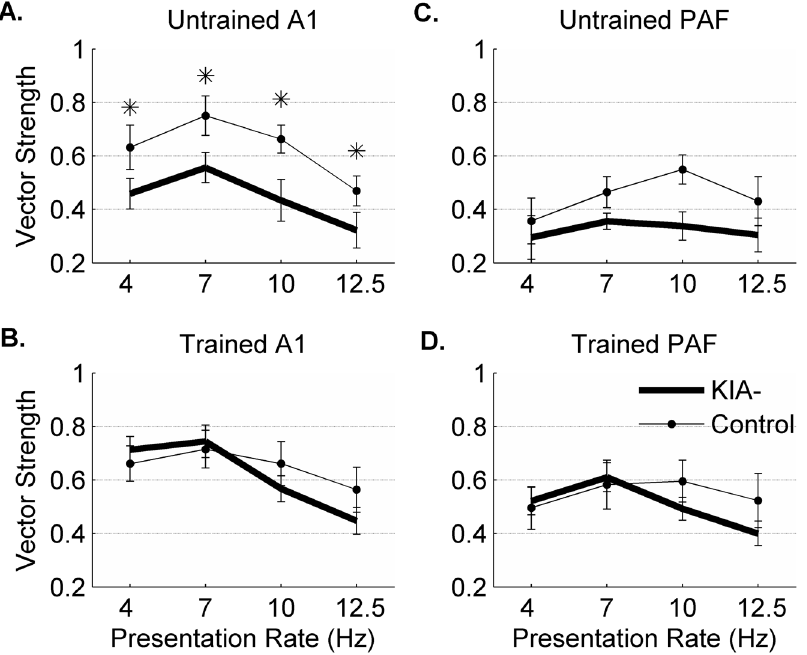
Figure 7. Training improves the ability of KIA- A1 and PAF sites to fire reliably to repetitive stimuli. A . Untrained KIA- A1 sites are significantly worse at following repetitive stimuli as measured by vector strength (*=p , 0.01). B . Vector strength in control and KIA- A1 following auditory training. C . Vector strength in untrained control and KIA- PAF sites. D . Vector strength in control and KIA- PAF following auditory training.